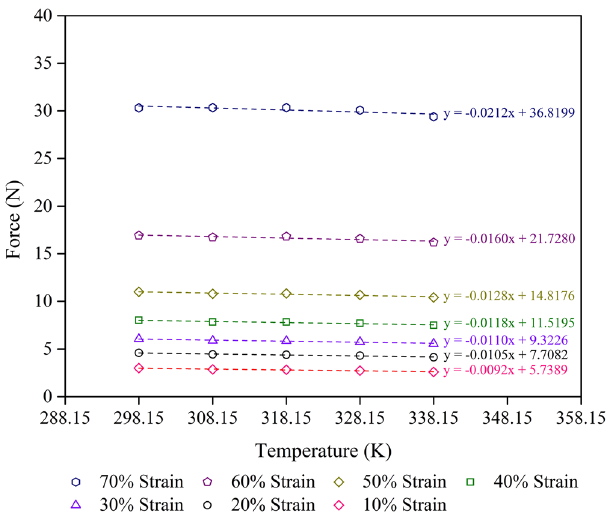
Figure 7. Force–temperature curves at a given strain for the control sample with R 2 = 0.9 minimum at each strain. The scatter on the results is on the order of the size of the figures.